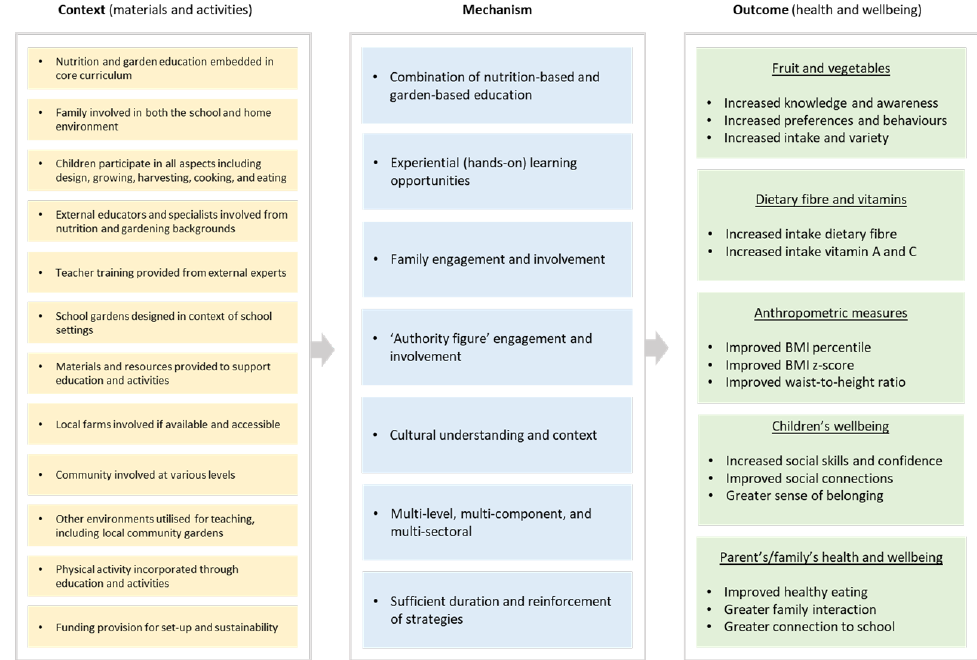
Figure 2. Context, mechanism, and outcome synthesis of school gardening interventions.